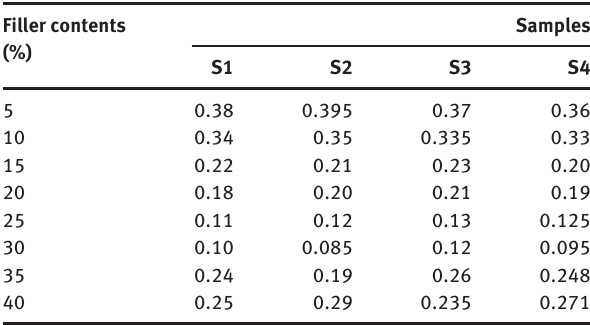
Table 3: Friction coefficients of the raw CNS filler epoxy composites with various filler contents.